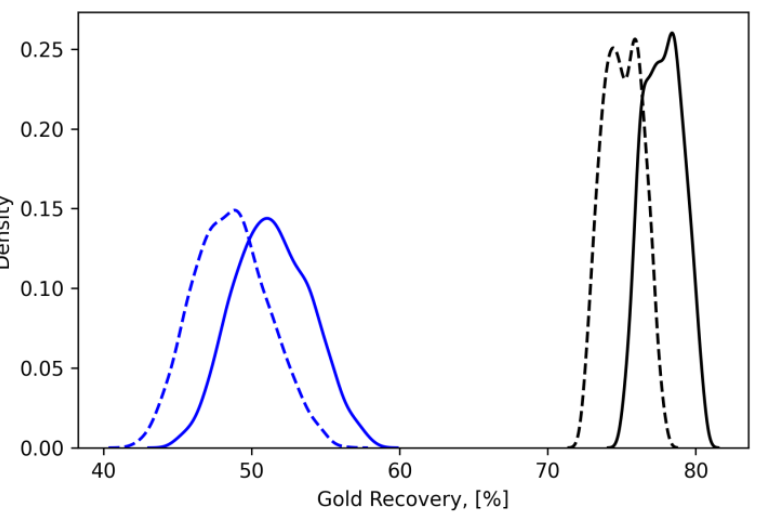
Figure 4. Distributions of the gold recovery of the studied systems. Blue distributions correspond to sodium thiosulfate, and black distributions correspond to sodium cyanide. The dashed lines are the systems that do not include Hg treatment. The continuous lines are the systems that include Hg treatment.